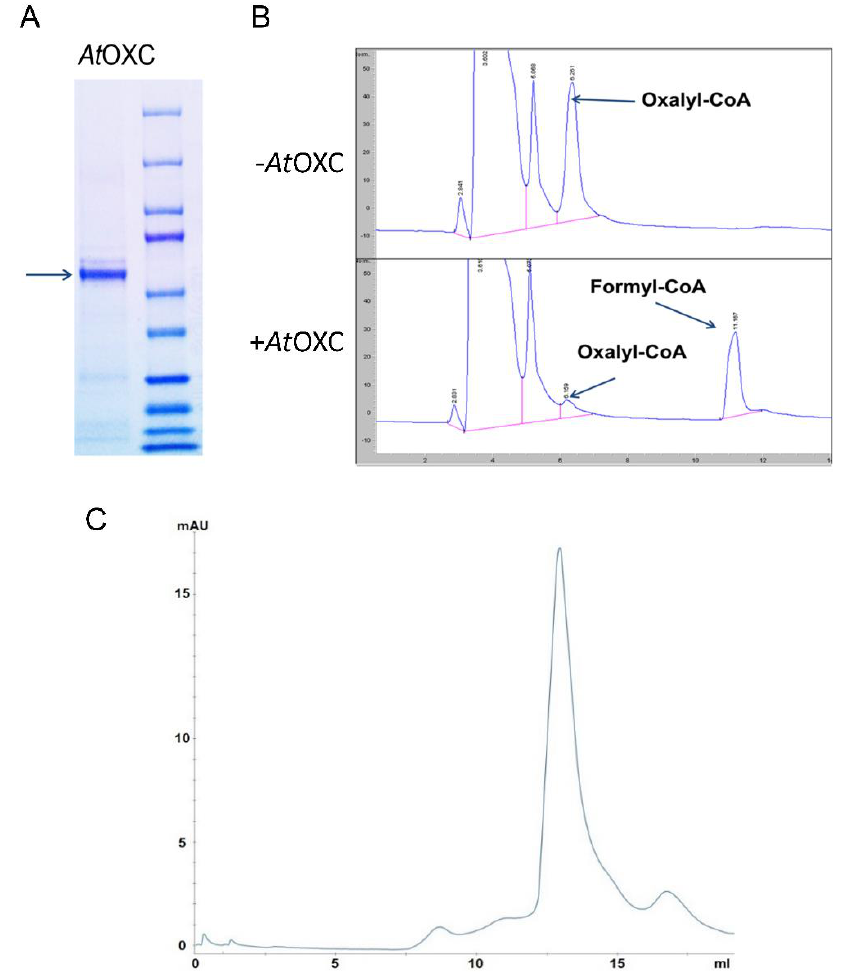
Figure 3. Biochemical analysis of AtOXC. ( A ) SDS-PAGE gel of nickel-affinity-purified His-AtOXC protein ( left ) and molecular weight markers ( right ). ( B ) HPLC analysis of enzyme reaction mix without and with added AtOXC. ( C ) Size exclusion chromatography of AtOXC using a Superdex 200 Increase 10/300 GL column. A dimeric form of AtOXC was detected during gel filtration using an Ä KTA purifier (GE Healthcare).